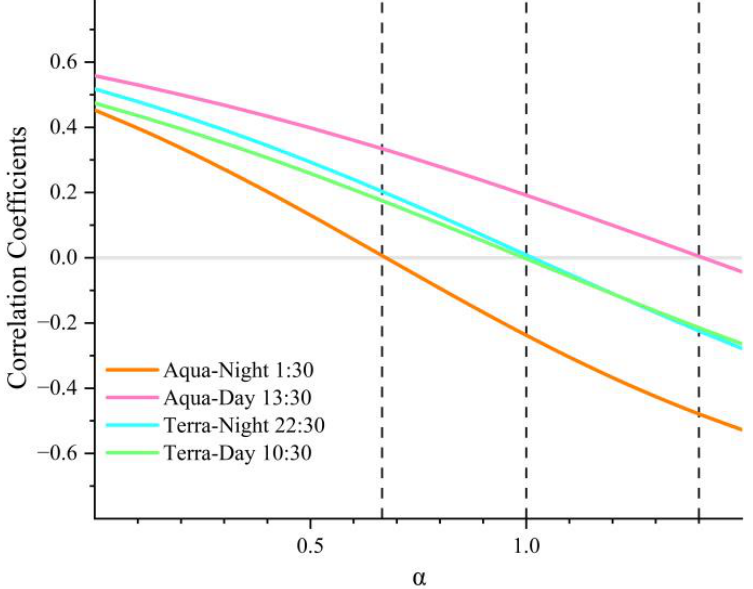
Figure 3. Pearson product moment correlation coefficient between ∆ LST ∆ T values. The abscissa is the value of α and the ordinate is the correlation coefficient between ∆ LST ∆ T 𝛼 and ∆ T air .